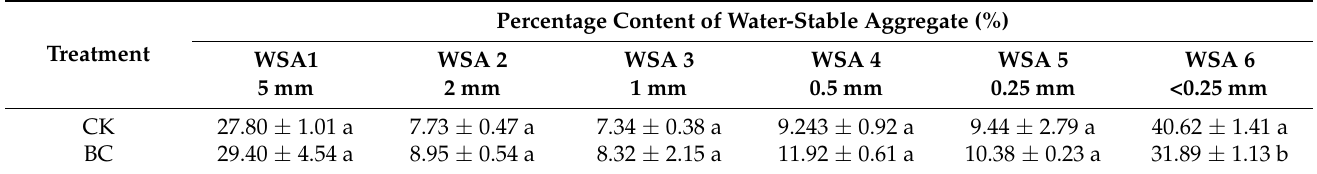
Table 1. Effects of biochar on soil water-stable aggregates in dry direct-seeded rice field. Treatment Percentage Content of Water-Stable Aggregate (%)